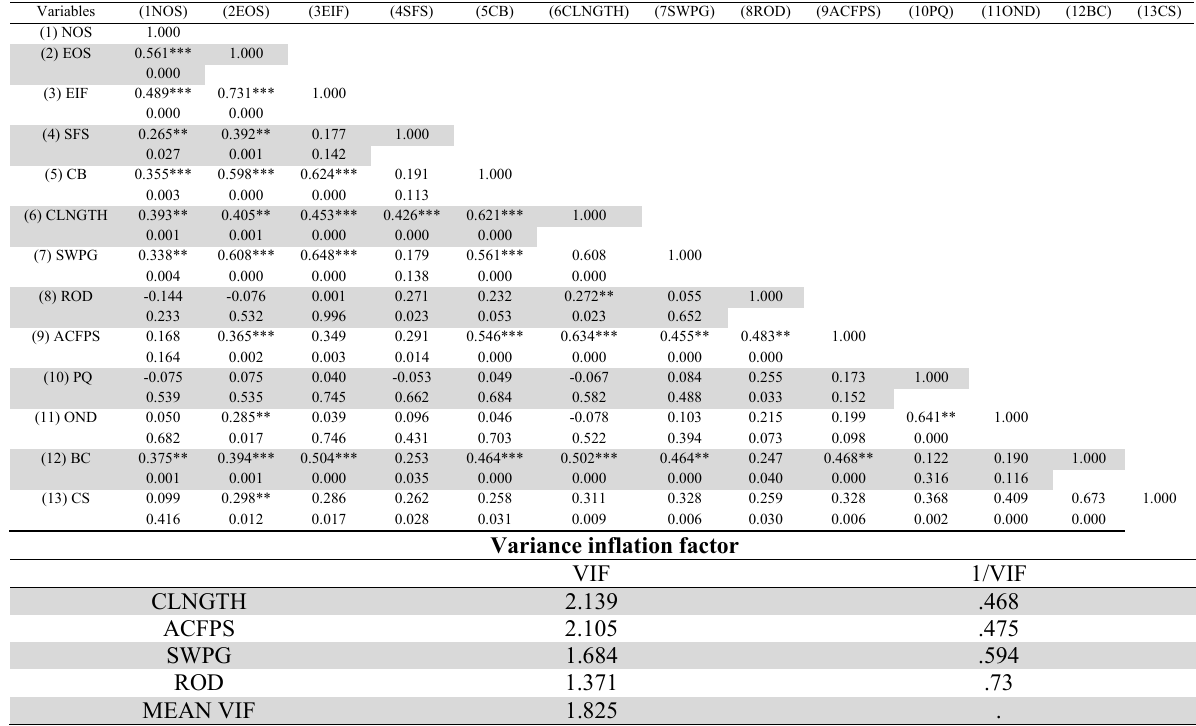
Effect of Contract Management Firm performance